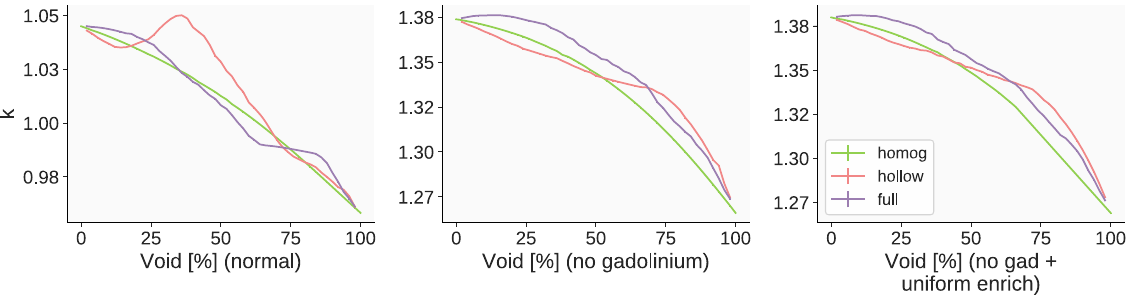
Figure 3: Criticality as a function of void for a normal lattice, a lattice with gadolinium removed and a lattice with uniform